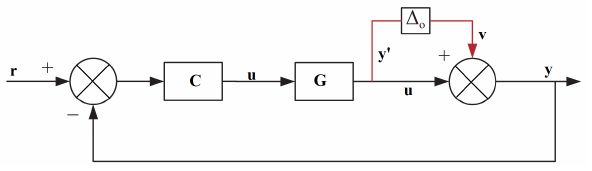
Figure 5. Multiplicative output uncertainty schematic